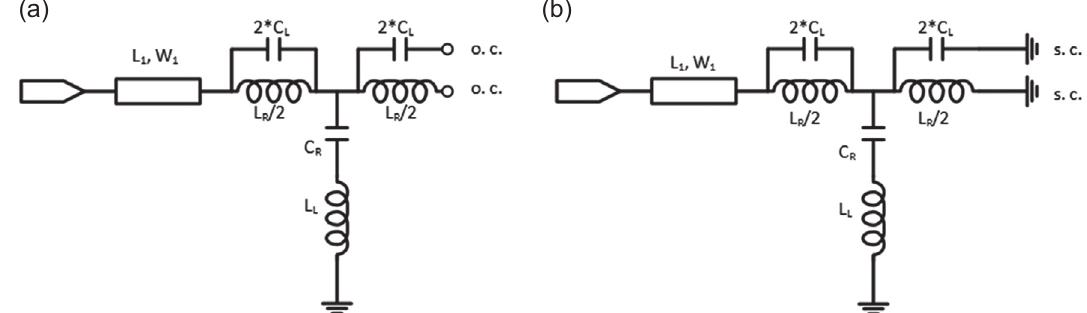
Figure 6. (a) Even mode excitation, (b) odd mode